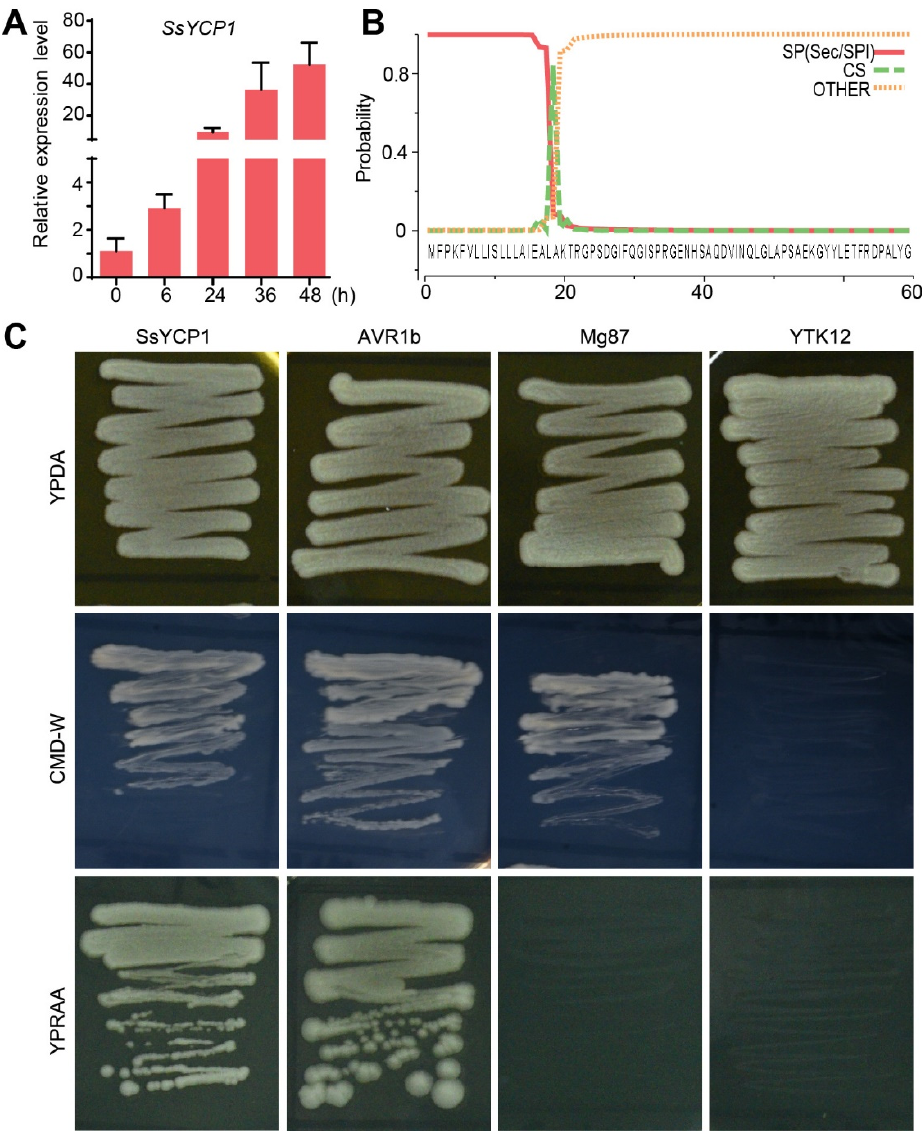
Figure 1. SsYCP1 is strongly expressed and secreted during S. sclerotiorum infection. ( A ) Expression of SsYCP1 at various times after S. sclerotiorum inoculation. Leaves were inoculated with mycelial agar plugs and were sampled at 0, 6, 24, 36, and 48 h. Baseline expression of SsYCP1 (0 h) was set as 1. ( B ) Signal peptide prediction in SsYCP1 protein by SignaIP-5.0. ( C ) Functional verification of